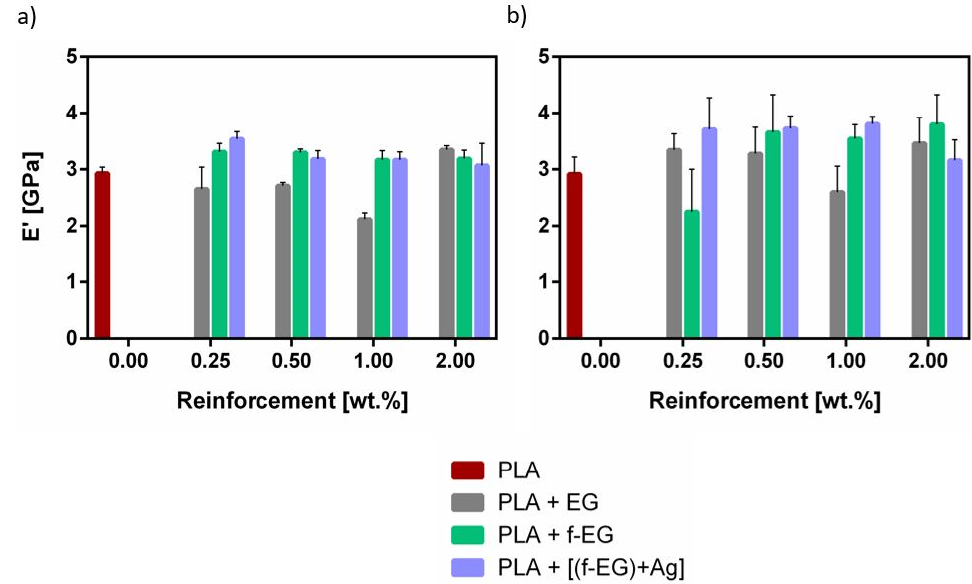
Figure 15. Storage modulus (E’) at 37 °C of ( a ) Fil3D and ( b ) FilText.